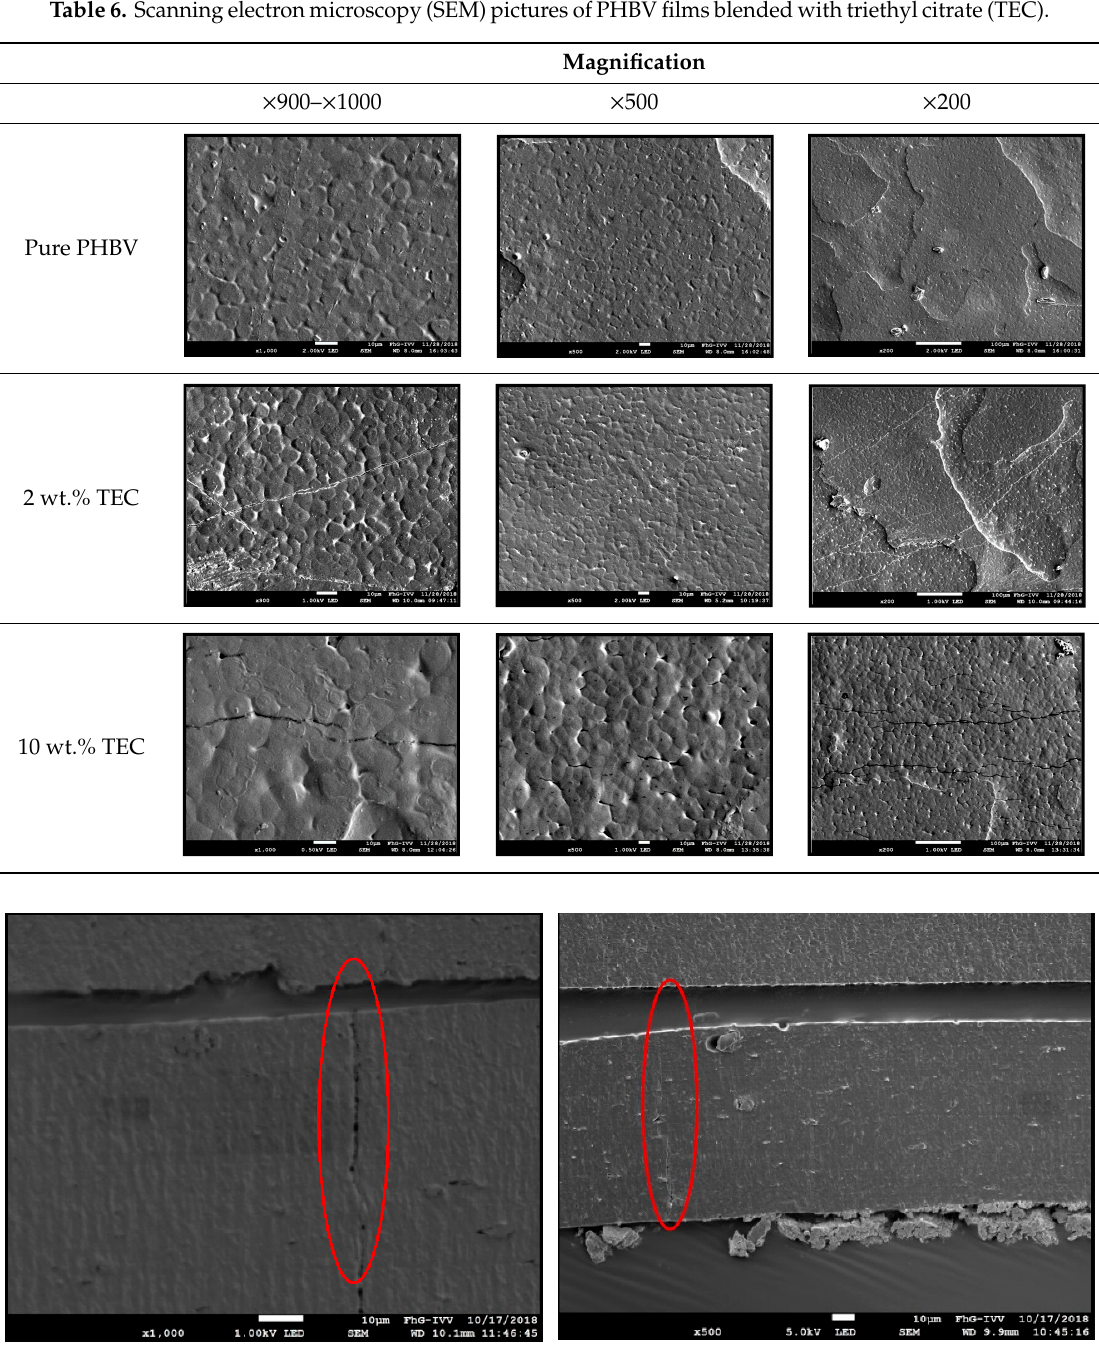
Coatings 2019 , 9 , x FOR PEER REVIEW 26 of 30 Figure 17. Atomic force microscopy (AFM) measurements of PHBV film with 15 wt.% PEG. left , extrusion temperature: 176 °C (MFR = const.); right , extrusion temperature: 185 °C (T = const.).